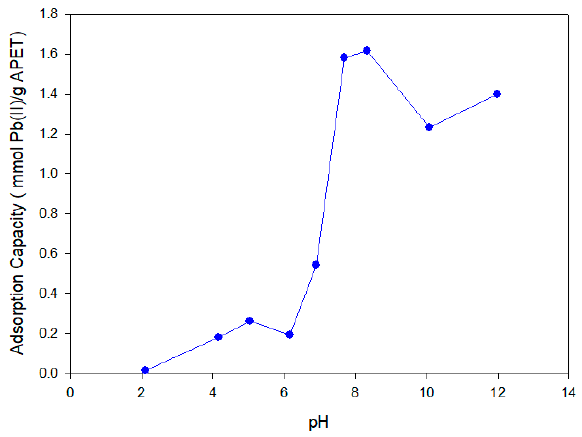
Figure 5. Effect of the initial pH on the Pb(II) adsorption with aminated poly(ethylene terephthalate) (APET) nanofiber mats.